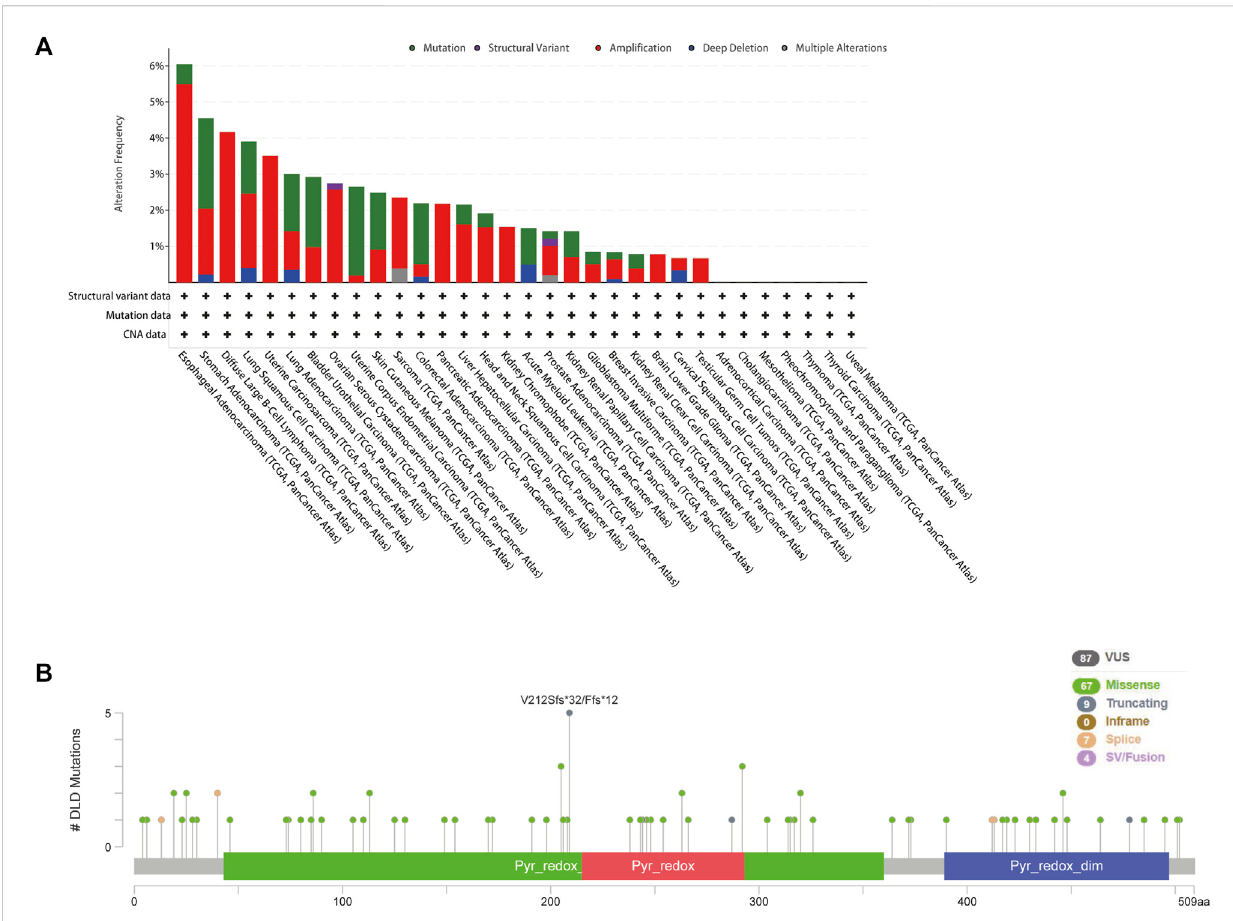
FIGURE 5 Genetic alterations of DLD in pancancer data from the cBioPortal tool. (A) The mutational status of DLD ineach type of cancer. (B) The mutated site and main mutation types of